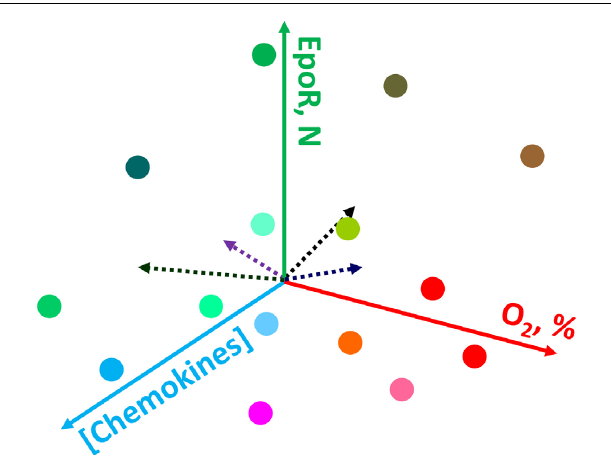
FIGURE 2 | Schematic representation of the possible causes of heterogeneity for erythroid precursor cells within bone marrow. Gradients in oxygen availability, chemokines and other signaling messengers create a plethora of conditions in which cells find themselves during differentiation. For details see the